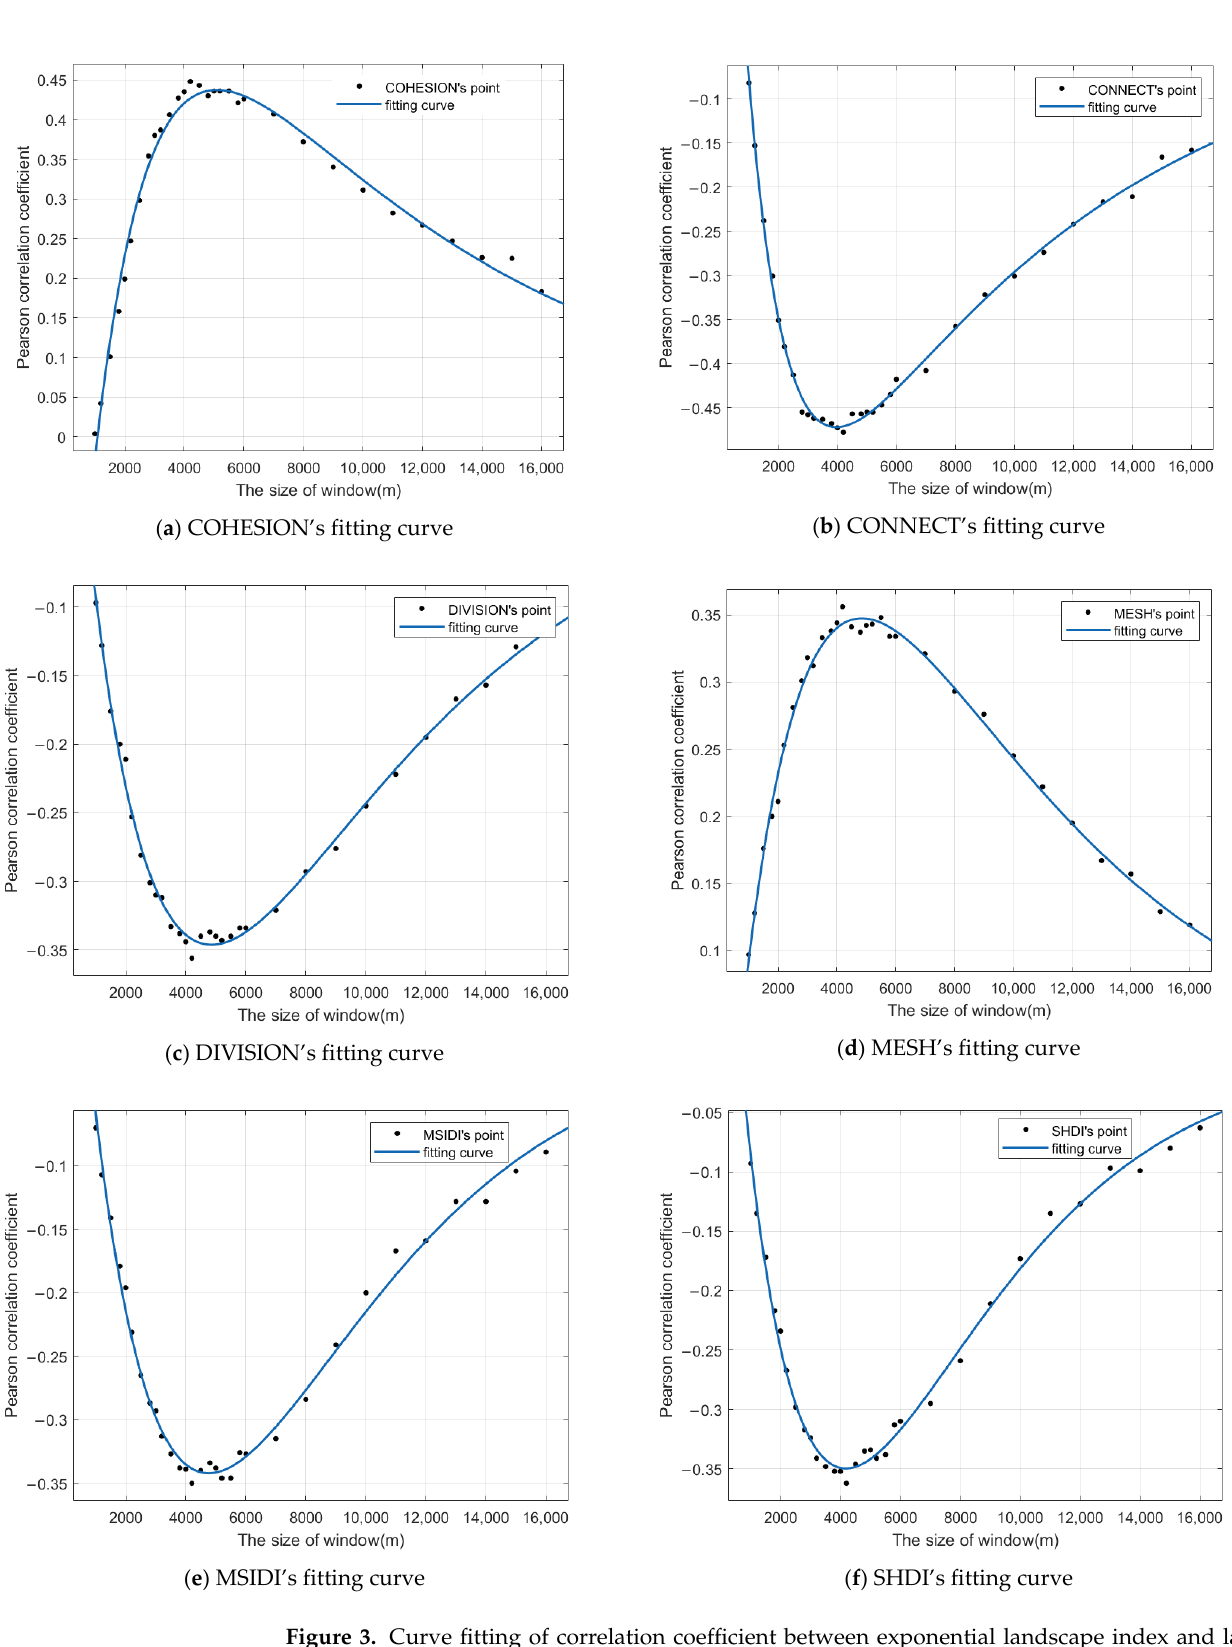
Figure 3. Curve fi tt ing of correlation coe ffi cient between exponential landscape index and land sur- Figure 3. Curve fitting of correlation coefficient between exponential landscape index and land face temperature. The subplot contains the results of di ff erent landscape indices. surface temperature. The subplot contains the results of different landscape